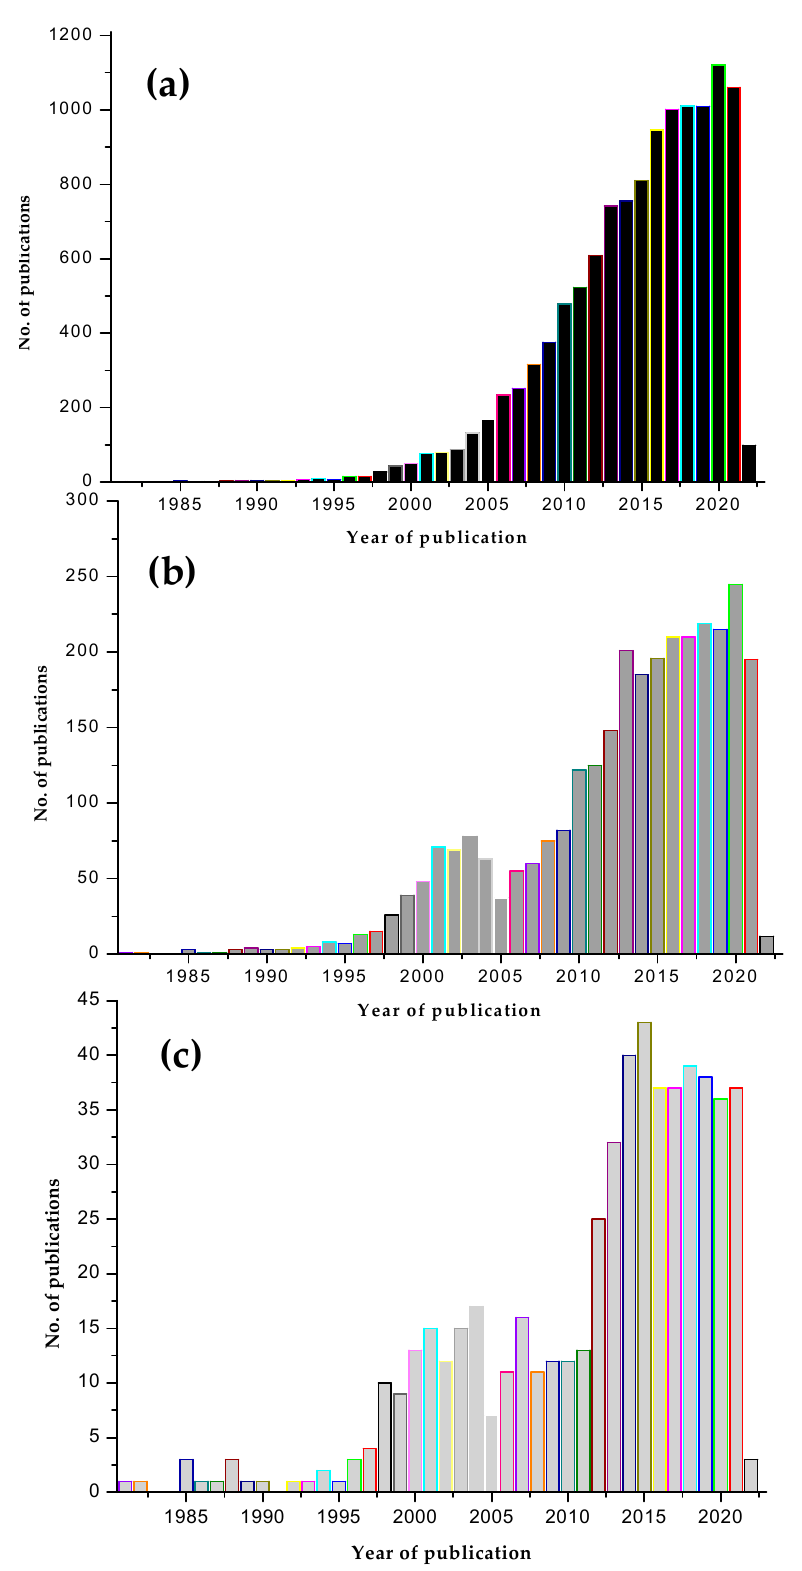
Figure 4. Comparative bar diagrams of research articles published in the area of ( a ) chitosans and drug delivery ( b ) chitosan derivatives and drug delivery ( c ) chitosan derivatives for oral drug delivery, based on our pubmed search.